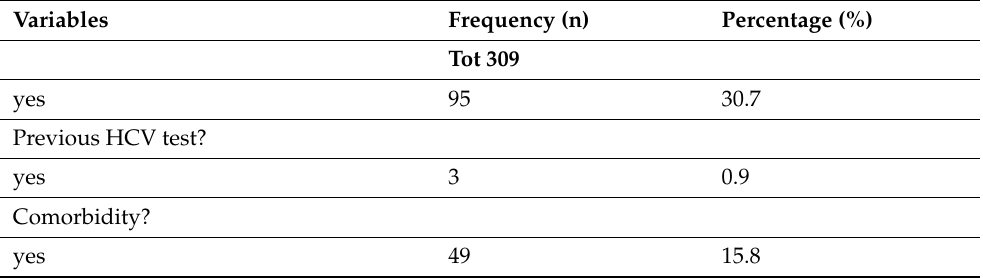
Table 1. Cont. Variables